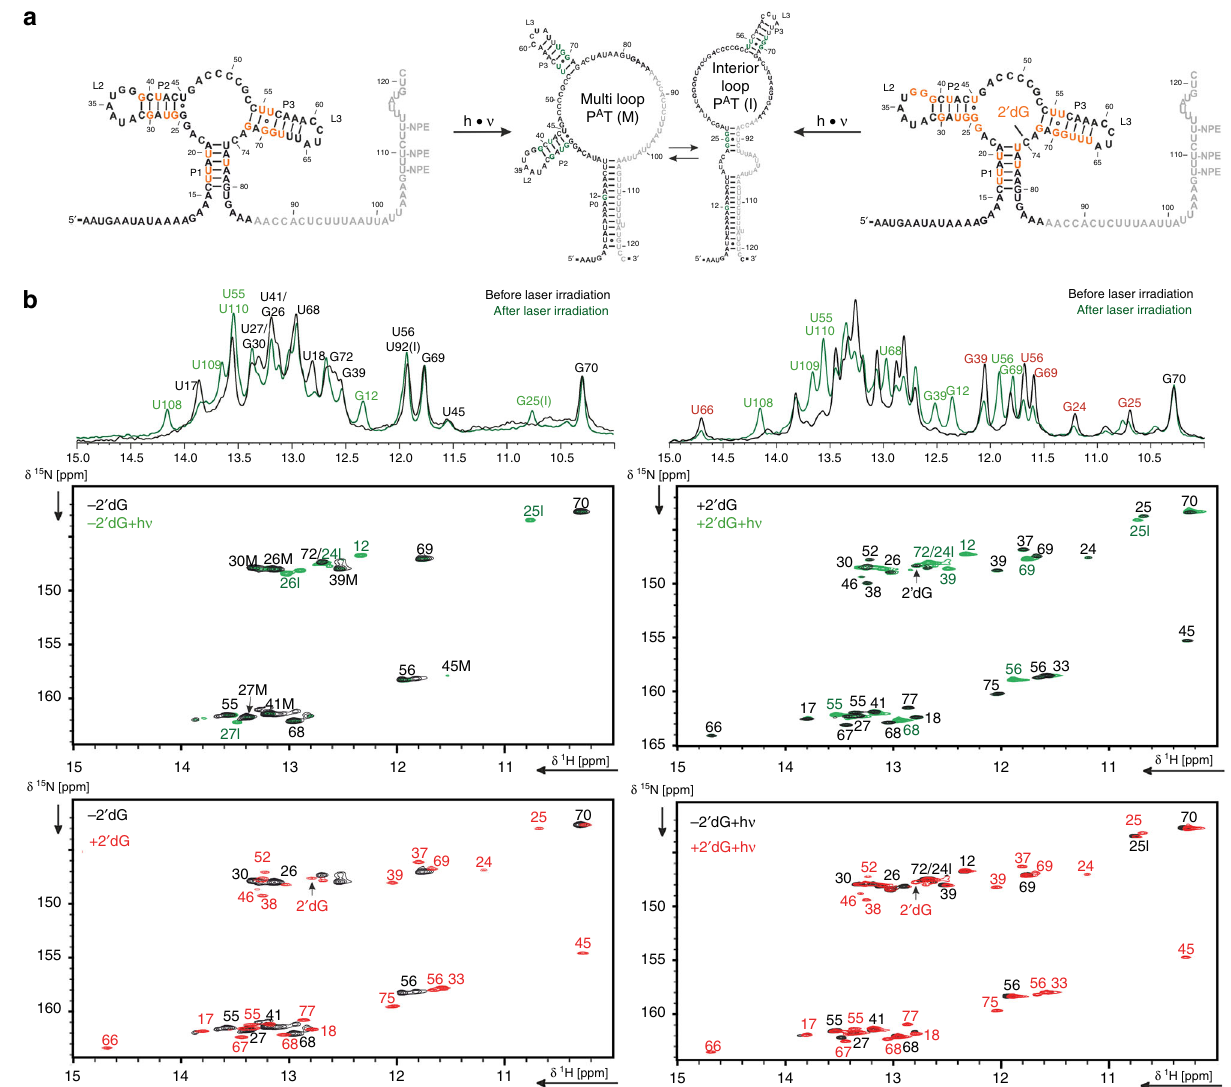
Fig. 2 Structural integrity of caged dGsw 121 before and after laser irradiation. a Secondary structures of dGsw 121 in presence and absence of ligand, before photolysis (PA – T) and after photolysis to form the antiterminator conformations P A T(M) and P A T(I). Aptamer domain imino protons detectable by NMR are highlighted in orange. Antiterminator imino protons detectable by NMR are highlighted in green. b Overlay of 1D NMR spectra of caged dGsw 121 before (black) and after (green) laser irradiation in absence (left) and presence (right) of 2 eq. of ligand and combinations of overlay of 1 H, 15 N -TROSY of dGsw 121 in absence ( − 2 ′ dG) or presence of 2 eq. ligand ( + 2 ′ dG), and before and after ( + h ν ) laser irradiation. The spectra were recorded on 100 µ M NMR samples with 6 eq. of Mg 2 + at 800MHz and 298 K. Characteristic imino proton signals to monitor the formation of P A T are highlighted in green. Characteristic imino proton signals to monitor aptamer dissociation in the presence of ligand are highlighted in